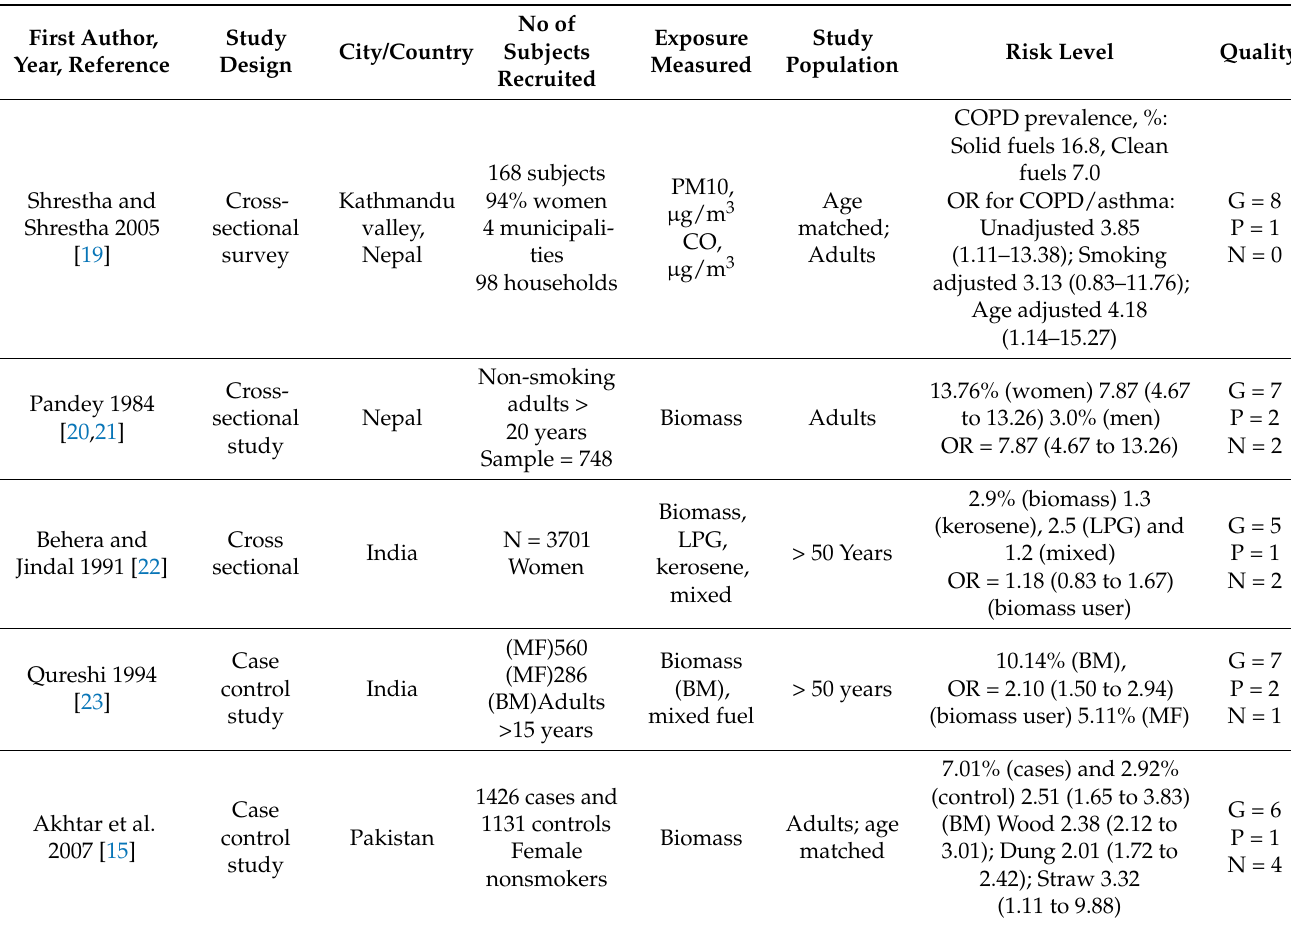
Table 4. Odds ratios of studies showing COPD